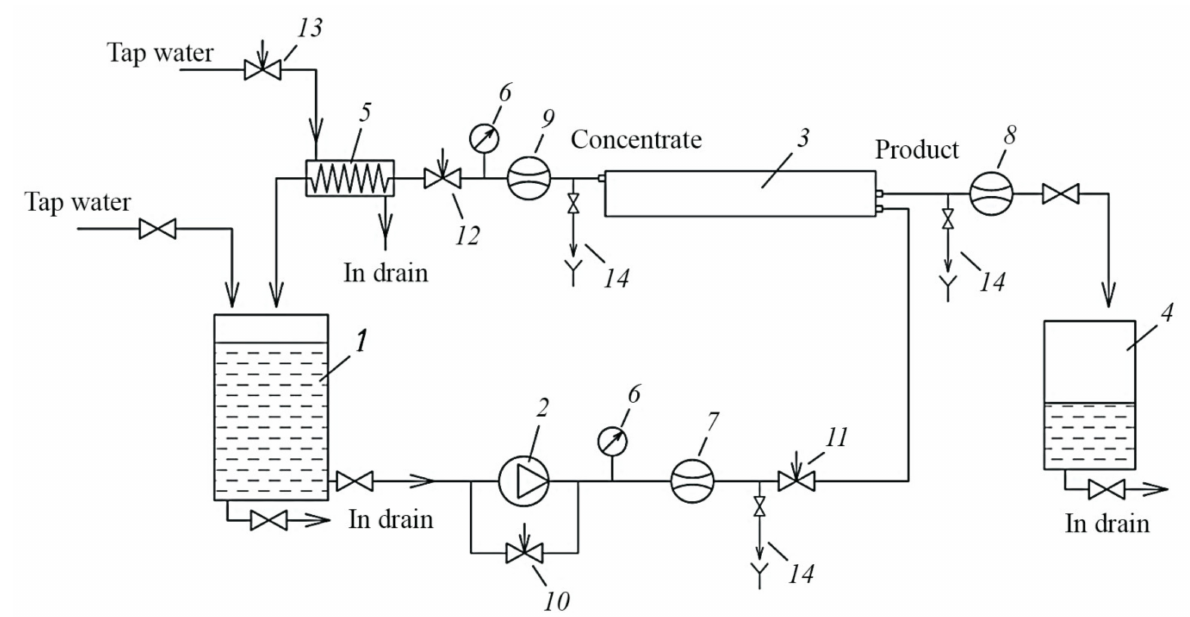
Figure 4. Schematic diagram of laboratory RO unit for membrane scaling tests: 1—feed water tank; 2—pump; 3—spiral wound membrane module; 4—permeate tank; 5—heat exchanger; 6—pressure gauge; 7—feed water flow meter; 8—permeate flow meter; 9—concentrate flow meter; 10—by-pass adjusting valve; 11—feed water adjusting valve; 12—concentrate adjusting valve; 13—cooling water adjusting valve;